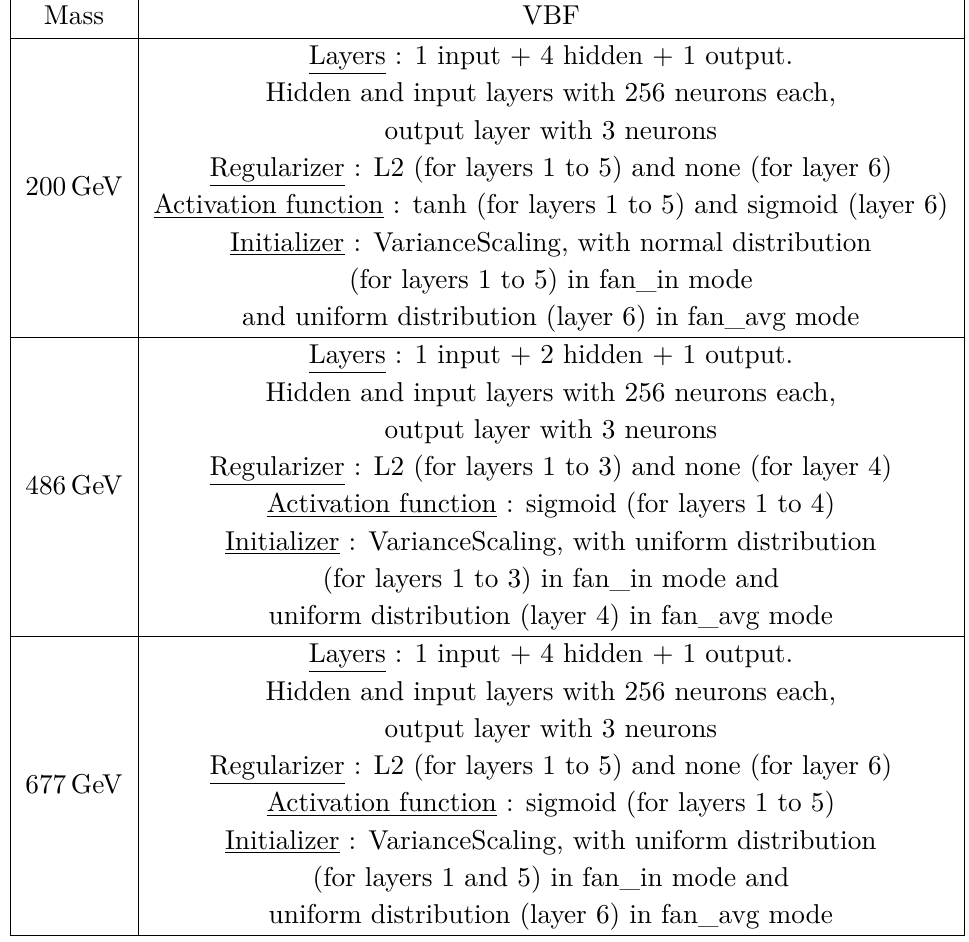
Table 14. Neural networks architectures employed for each mass of the lightest VLL for VBF. The architecture is determined following the implementation of an evolutive algorithm that maximises the Asimov